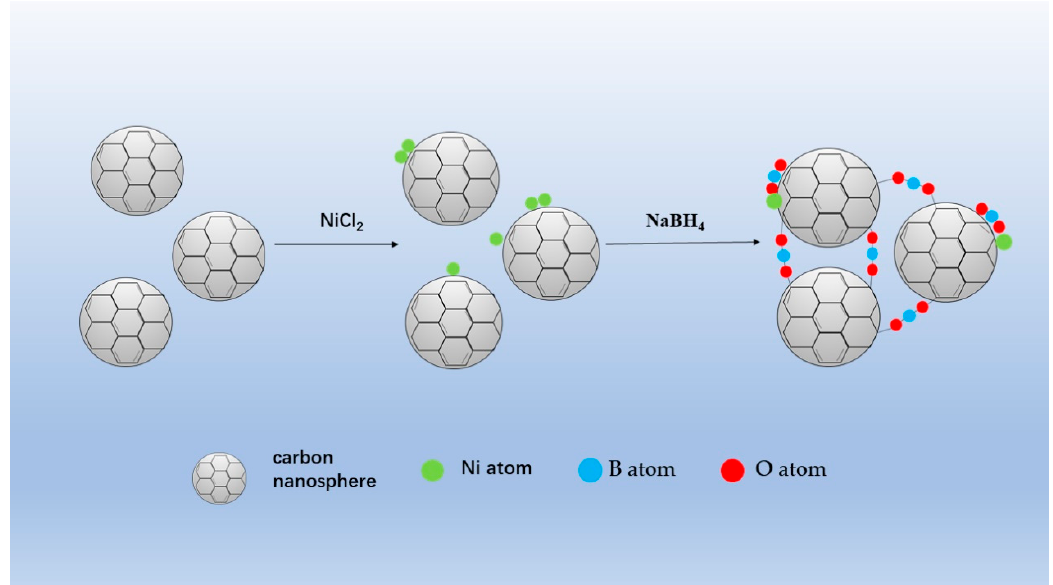
Scheme 1. Schematic representation of the formation mechanism of B-ECP600.